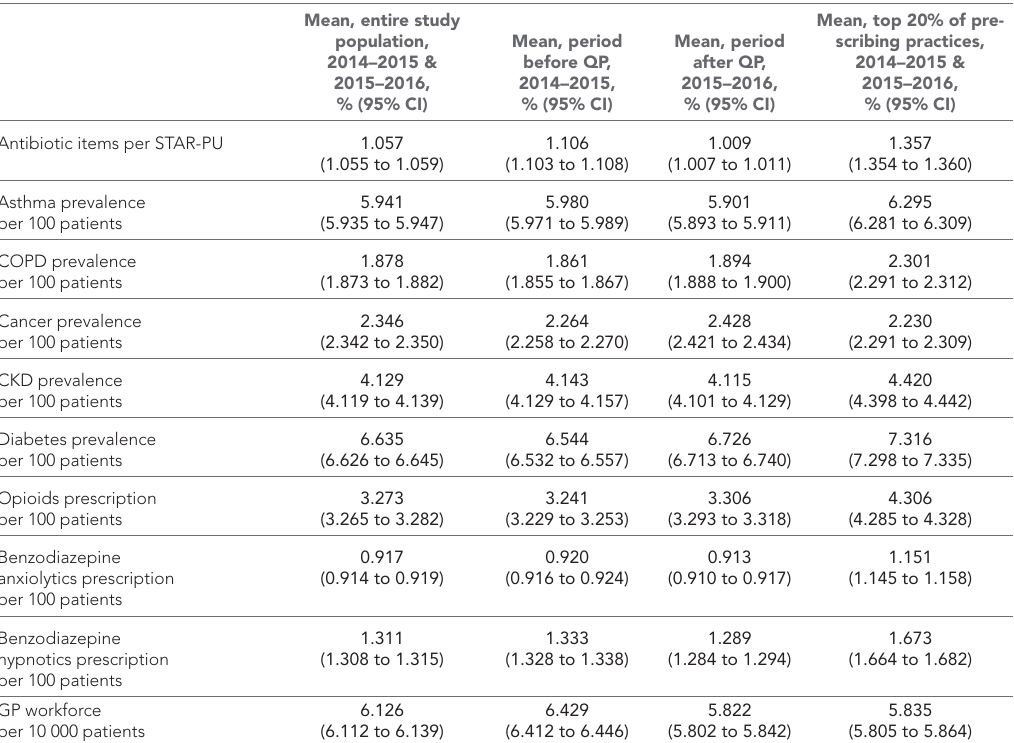
Table 1 Characteristics of general practices, N = 6251 Mean, entire study